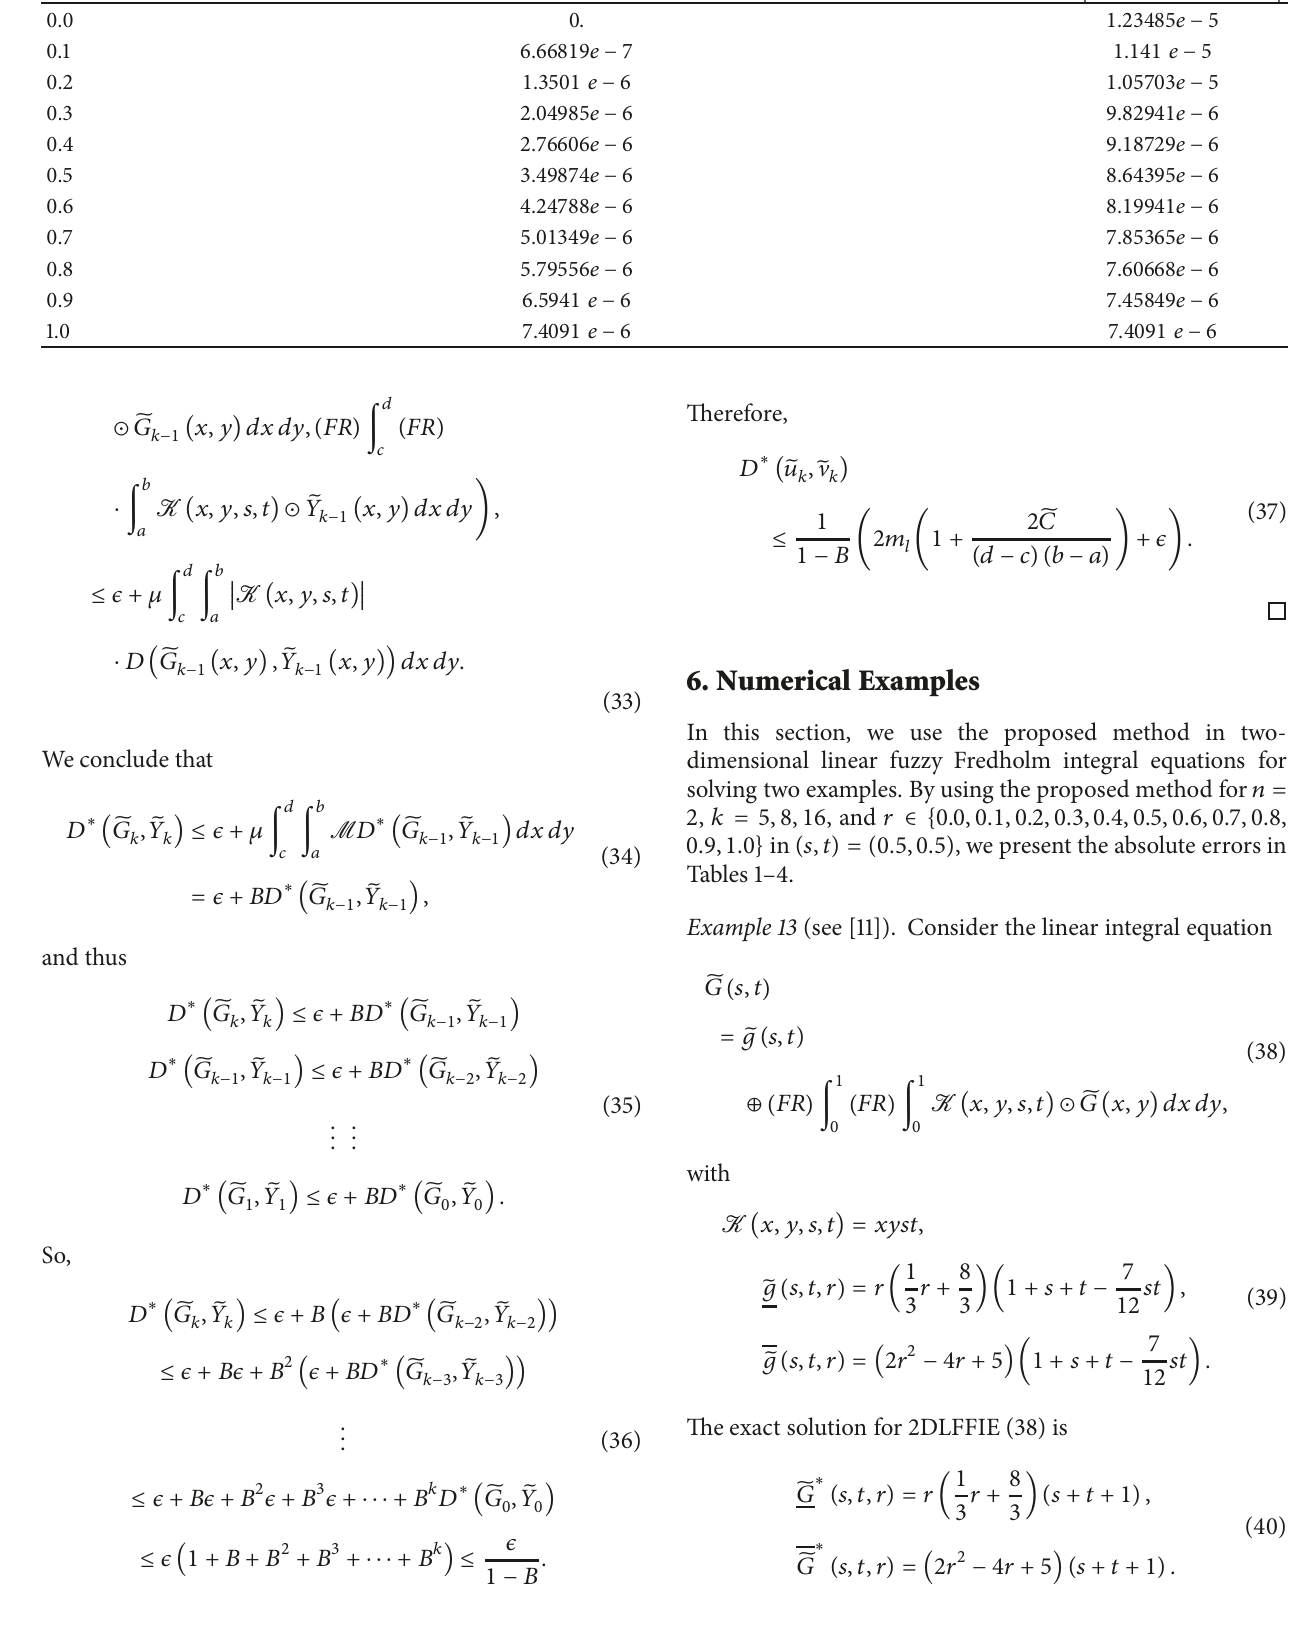
󵄨󵄨󵄨󵄨󵄨󵄨󵄨̃𝐺 ∗ 𝑟)󵄨󵄨󵄨󵄨󵄨󵄨󵄨 𝑒 𝑟 = (𝑠,𝑡, 𝑟) − ̃𝑢 (𝑠,𝑡, 𝑘